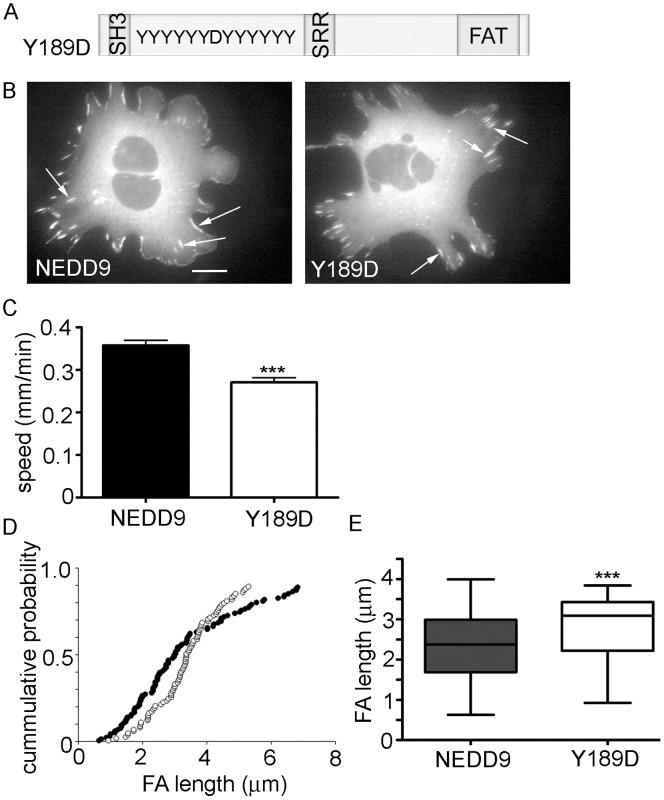
NEDD9Y189D phospho-mimetic inhibits migration and increase focal adhesion lengths.A. Schematic representation of NEDD9 protein sequence showing the Y189D mutation. B. NEDD9−/− MEFs transfected with GFP.NEDD9 or GFP.NEDD9Y189D, as indicated. Arrows point to examples of positive focal adhesions. Scale bar = 20 µm. C. Average speed of NEDD9−/− fibroblasts transfected with the indicated GFP expression plasmids. Graphs show the average (n>100 cells per expression construct) and SEM. ***p<0.001. D. Fraction of focal adhesions versus adhesion length. Data for GFP.NEDD9 show in black circles (n = 112) and for GFP.Y189D in white circles (n = 96). E. Comparison of the fraction of focal adhesions less than 4 µm long. ***p<0.001.